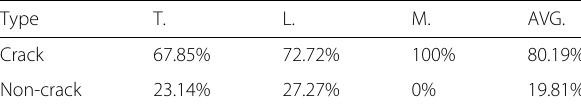
Table 5 Comparative results with Li et al. method for general